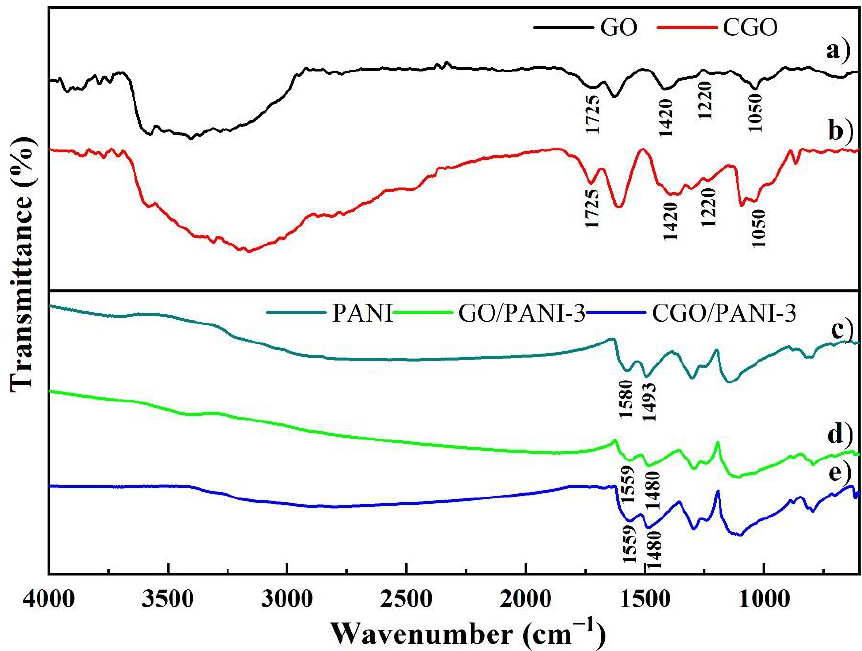
Figure 2. FT-IR spectra of ( a ) GO, ( b ) CGO, ( c ) PANI, ( d ) GO/PANI-3, ( e ) CGO/PANI-3.